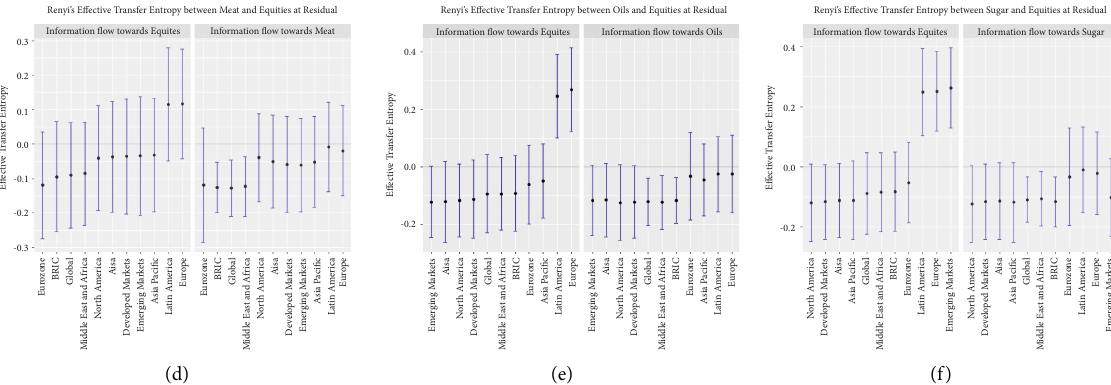
Figure 6: Transfer entropies in the long-term. Notes: This figure presents the quantified information flow between the returns on world food commodity and regional equity markets at the long-term scale (residual IMF). (a) to (f), respectively, represent ETEs for cereals, dairy, food, meat, vegetable oil, and sugar indices against the regional